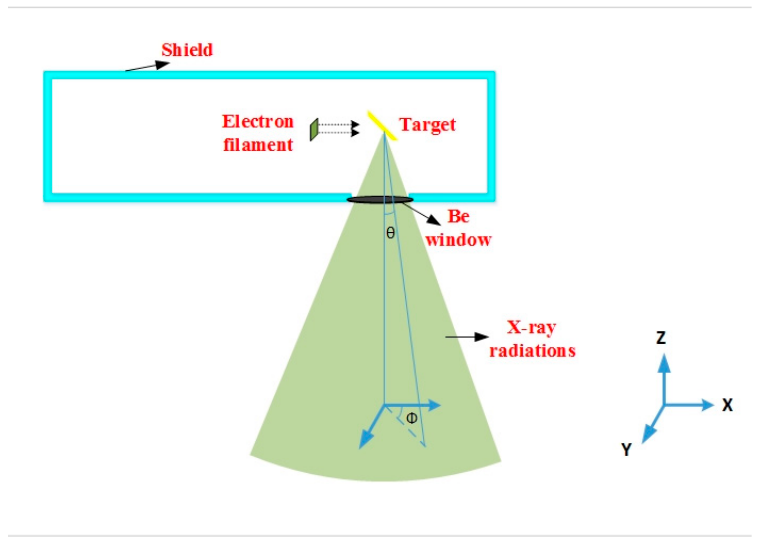
Figure 1. Schematic view of modeled X-ray tube.